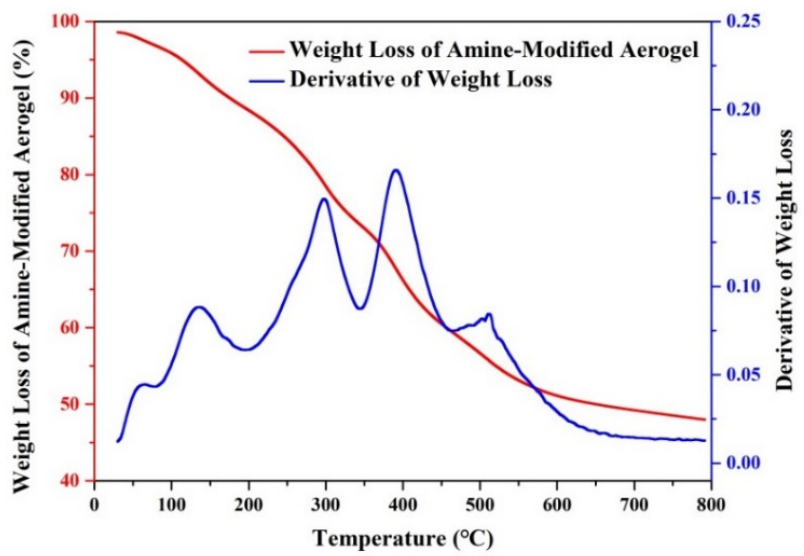
Figure 10. The TG analysis curve of the APTMS-modified Zr–Mg mixed oxide aerogels with Zr/Mg molar ratio of 7/3 under four APTMS modifications.